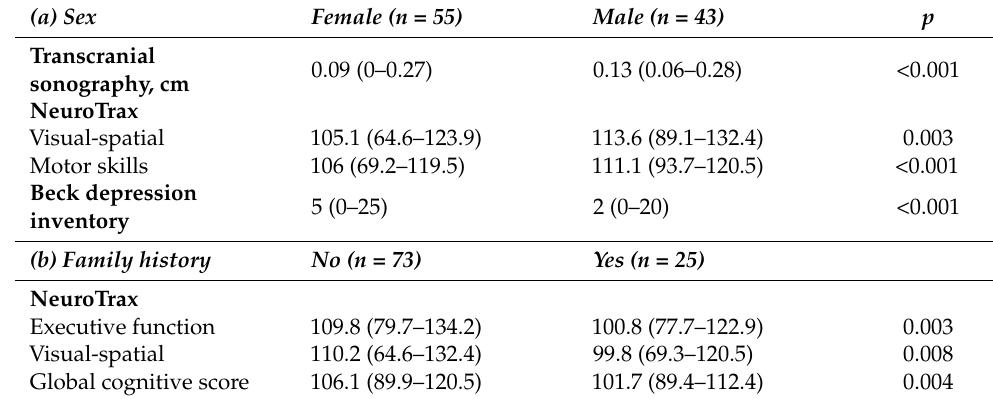
Table 3. Associations of sex and family history of Parkinson’s disease with abnormal prodromal tests *.